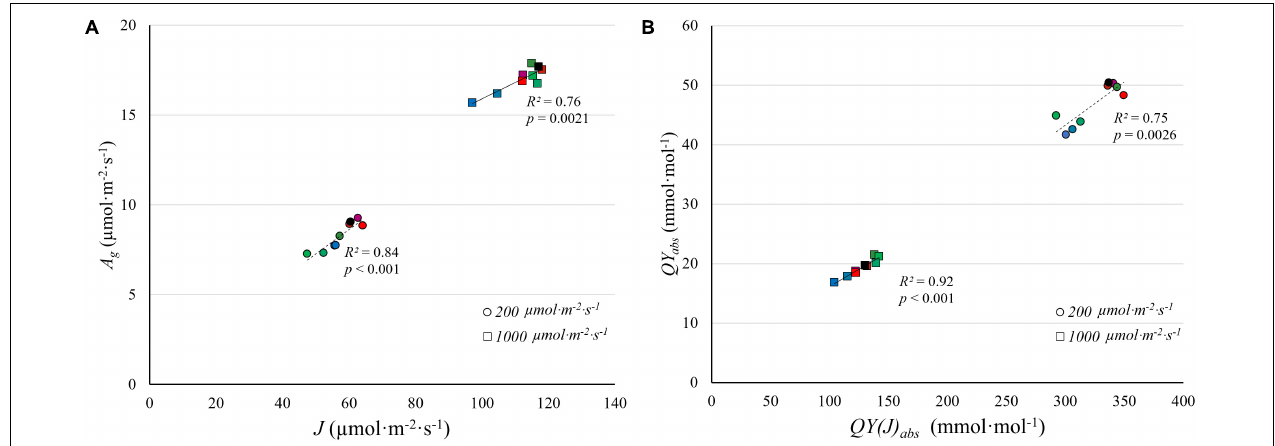
FIGURE 9 | The correlation between gross CO 2 assimilation rate ( A g ) estimated from light response curves and electron transport rate ( J ) estimated from A/C i curves (A) , and between the quantum yield of CO 2 assimilation ( QY abs ) and the quantum yield of electron transport on an absorbed light basis [ QY(J) abs ] (B) , under low PPFD (200 µ mol m − 2 s − 1 ) and high PPFD (1,000 µ mol m − 2 s − 1 ) under nine light spectra averaged over nine “Green Towers” lettuce plants. The color scheme representing the nine spectra is the same as Figure 8